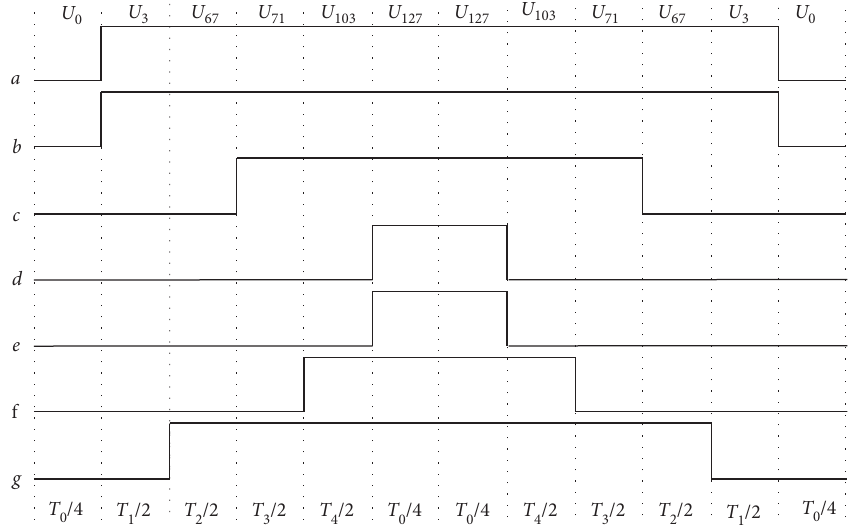
Figure 4: Switching signal of NFV-SVPWM algorithm in sector